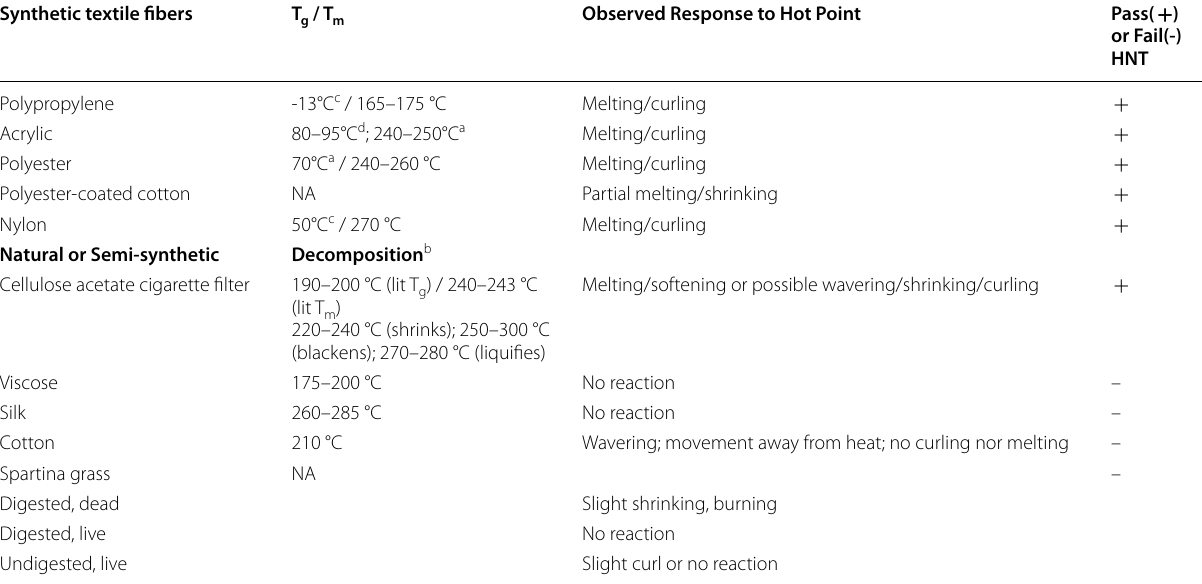
) or burning points and observed behavior towards the hot point of a m ) of polymers is provided from the g